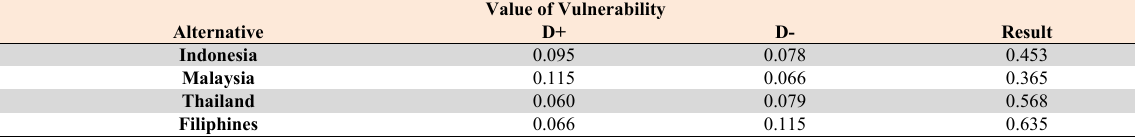
Fig. 6. Graphic of Risk Value to Islamic State (IS) Network in Southeast Asia